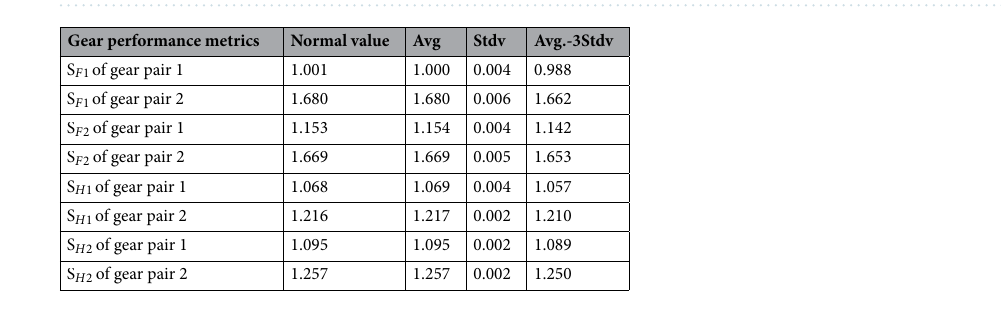
Table 5. Robust analysis results of safety factor for tooth root stress and surface durability of pinion and wheel of each gear